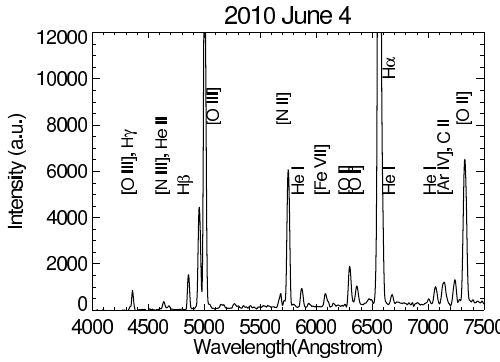
Figure 2: Optical spectrum of V5584 Sgr during the nebular stage (Poggiani, 2011) The line profiles are a signature of the ejecta distri- bution. Optically thin winds and optically thin shells show rounded and rectangular line profiles, respectively.